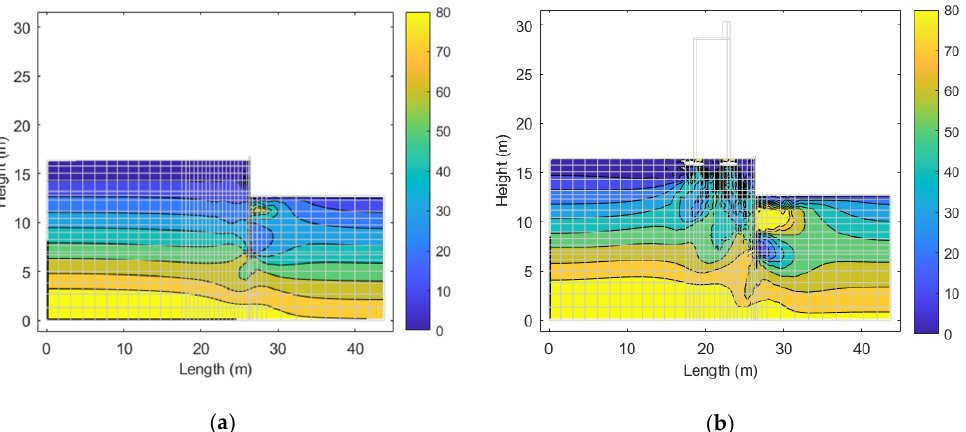
Figure 6. Horizontal stresses in the soil for: ( a ) the “‘retaining wall-only” case and ( b ) the “structure on the backfill” case.